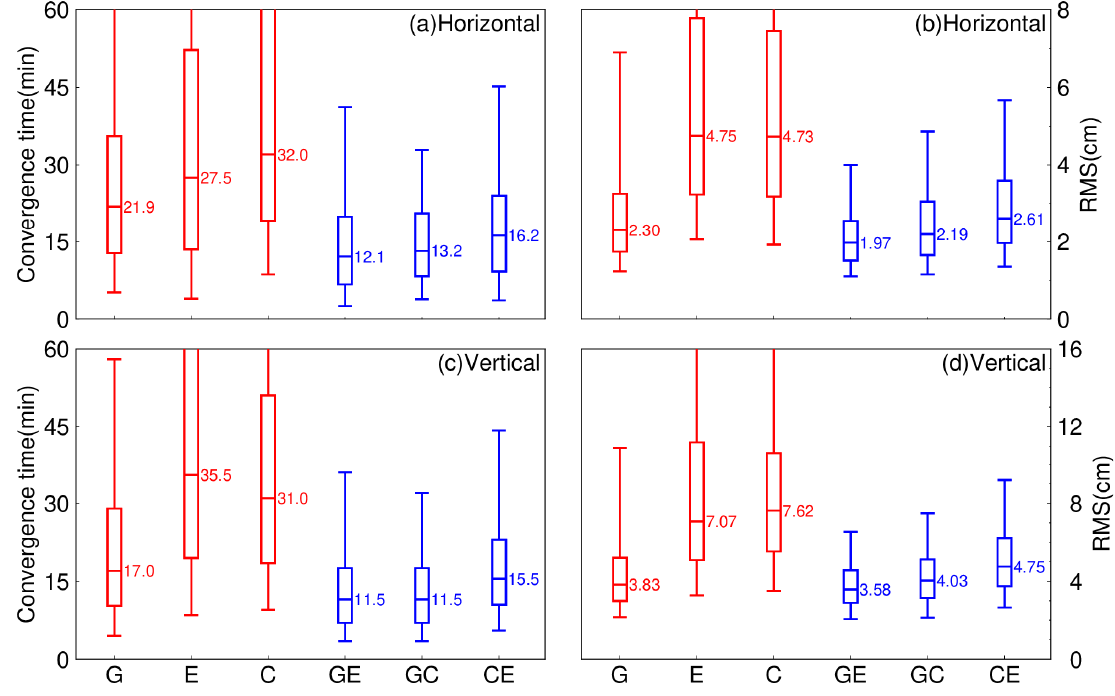
Figure 12. Distribution of the convergence time and RMS of kinematic PPP solutions for the single systems (G is short for GPS, E is short for Galileo, and C is short for BDS-3) and dual- system combinations (GE is short for GPS combined with Galileo, GC is short for GPS combined with BDS-3, and CE is short for BDS-3 combined with Galileo) in September 2022. ( a ) Horizontal component of convergence time, ( b ) Horizontal component of RMS, ( c ) Vertical component of convergence time, ( d ) Vertical component of RMS.